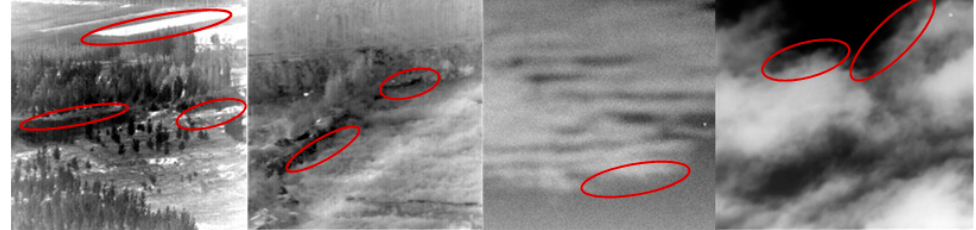
Figure 4. Edge areas in infrared images are displayed in red circle.